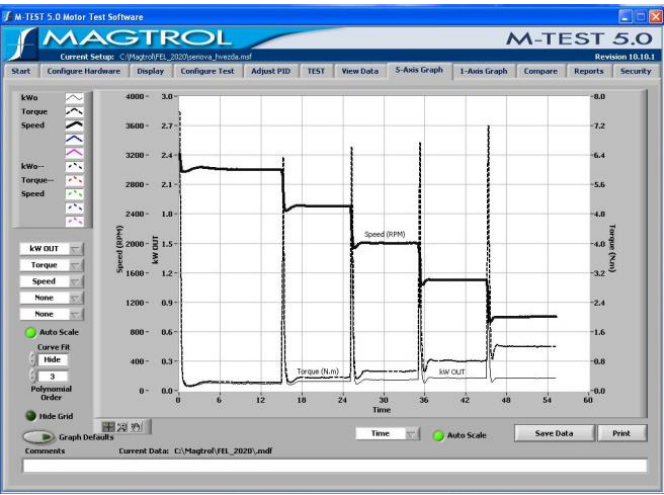
Figure 9. Software tool M-Test 5.0—Torque/Speed/Power progression with respect to time.